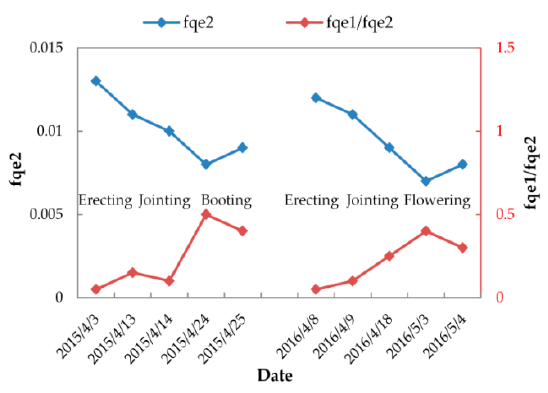
Figure 12. The correlation and relative root mean square error (RRMSE) values between simulated and measured SIF A and SIF B with variable FQE: ( a ) the correlation and RRMSE for 106 spectral measurements and ( b ) the RRMSE values for each fieldwork day in 2015 and 2016. On the other hand, if simulated with variable FQE values, the SCOPE model can credibly reproduce the seasonal SIF A /SIF B values. Similar to Figure 12, Figure 13 shows the correlation and RRMSE values between the diurnally simulated and measured SIF A /SIF B with variable FQE. Unlike the unsatisfactory results shown in Figure 10, with variable FQE, both the range and values of simulated SIF A /SIF B were consistent with the measured ones: for all 106 spectral measurements, most scatters are close to the 1:1 line with an R 2 of 0.48 and an RRMSE of only 20.63%, and most daily RRMSE were lower than 20% (with a range from 4.98% to 24.20%) on the ten fieldwork days.